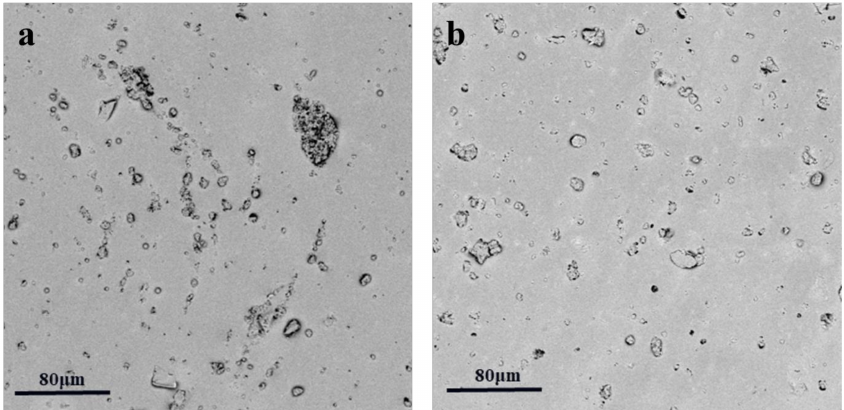
Figure 3. SEM images of dielectric composites PANI/PDMS ( a ), and PVP@PANI/PDMS ( b